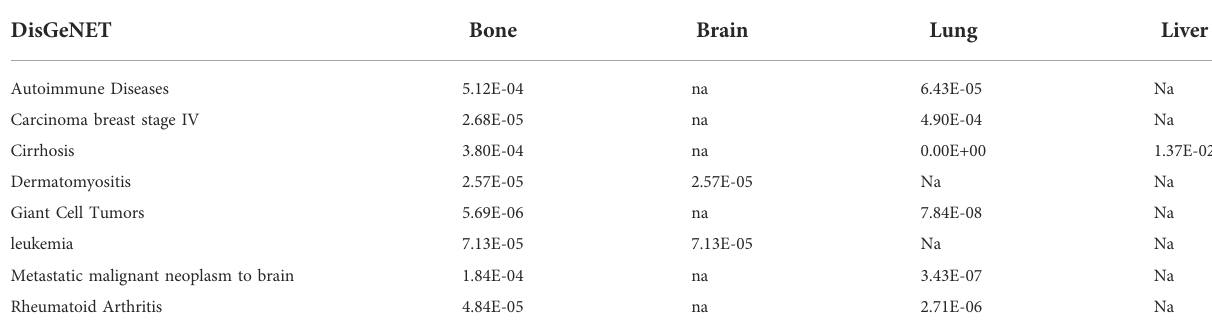
TABLE 3 DisGeNET enrichment